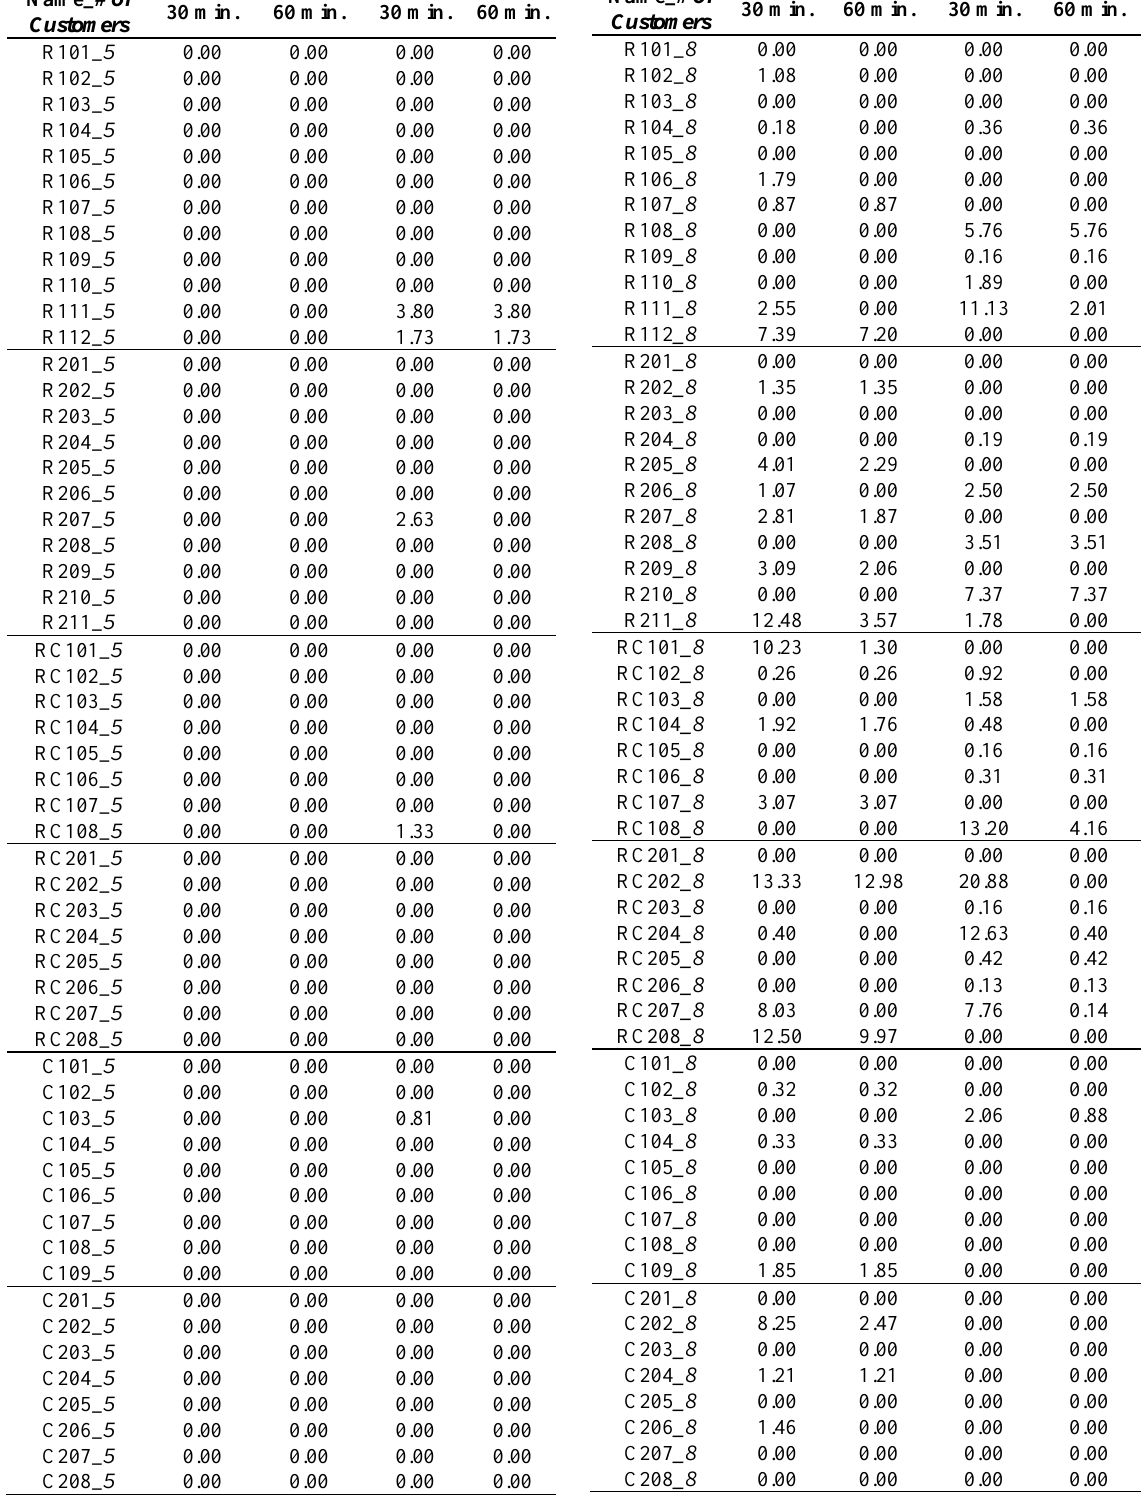
Table A1. The RPD results for instances with 5 customers. Table A2. The RPD results for instances with 8